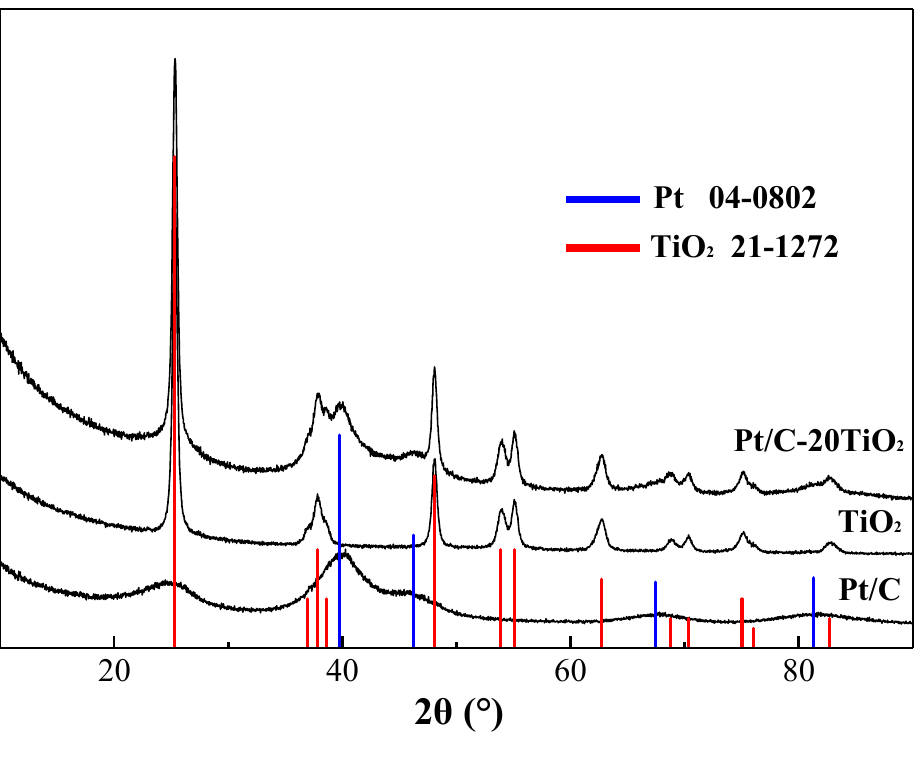
Figure 1. XRD patterns of Pt/C, commercial TiO 2 and Pt/C-20TiO 2 catalysts. As the high-resolution transmission electron microscopy (HRTEM) image in Figure 2a shows, the Pt nanoparticles are uniformly dispersed on the carbon supports with an average size of about 2.74 nm (Figure S1). A small Pt particle size and uniform dispersion potentially ensure good catalytic performance [34]. Figure 2b shows TEM images of the as-prepared Pt/C-20TiO 2 catalyst. The lattice fringes of 0.35 nm (red tags) and 0.22 nm (yellow tags) are assigned to the TiO 2 (101) plane and the Pt (111) plane, respectively. It can be seen that the TiO 2 and Pt particles are well contacted with each other.